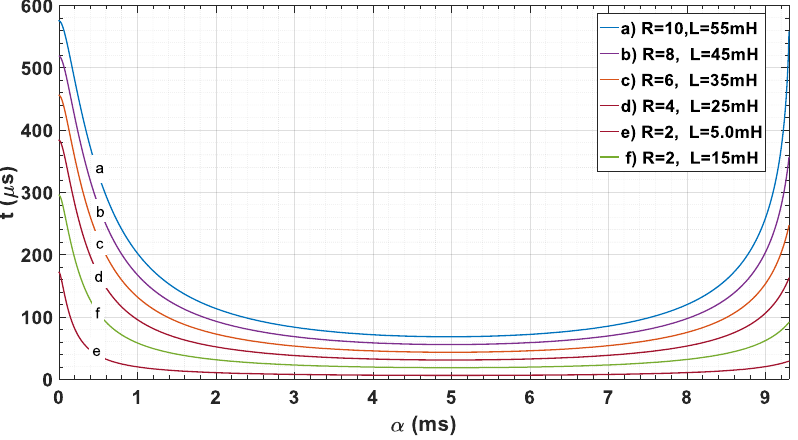
Figure 7. Minimum ignition time variation for different loads at V = 230 V and f = 50 Hz.